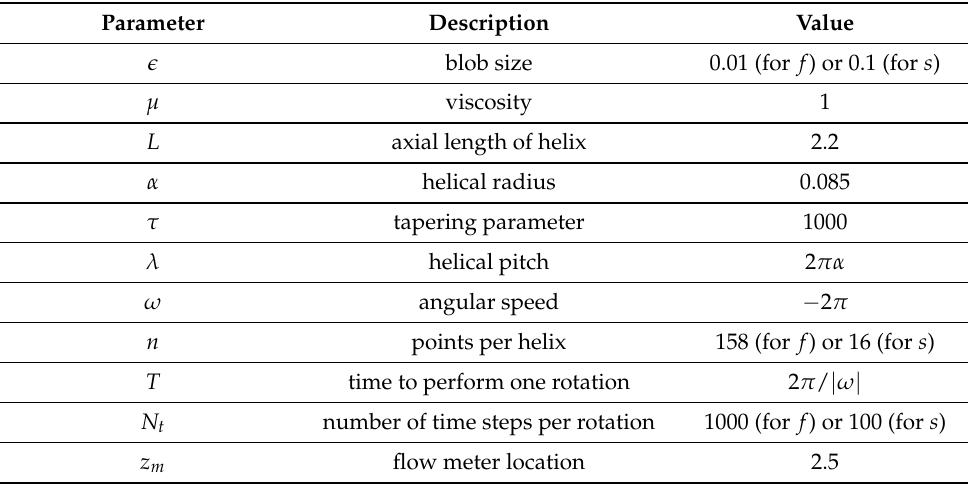
Table 1. Default parameter values given in non-dimensional units. Parameter